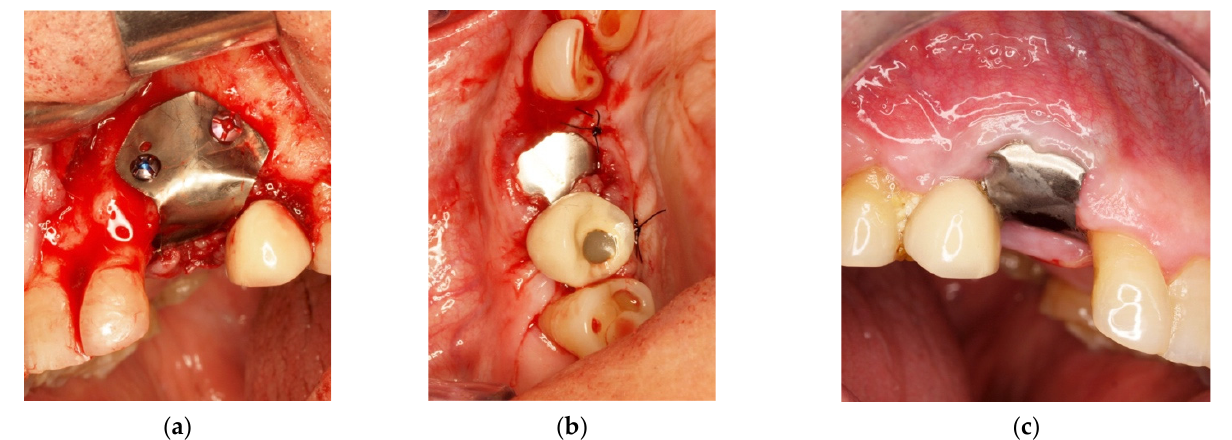
Figure 7. Peripheral blood clot with beta-tricalcium phosphate particles in granules. After the implant insertion, the enriched clot was put in the alveolar gap and protected by a shaped intra-operatory titanium foil, fixed with screws on both buccal and palatal walls. It sutured, leaving the foil exposed (Figure 8a,b).